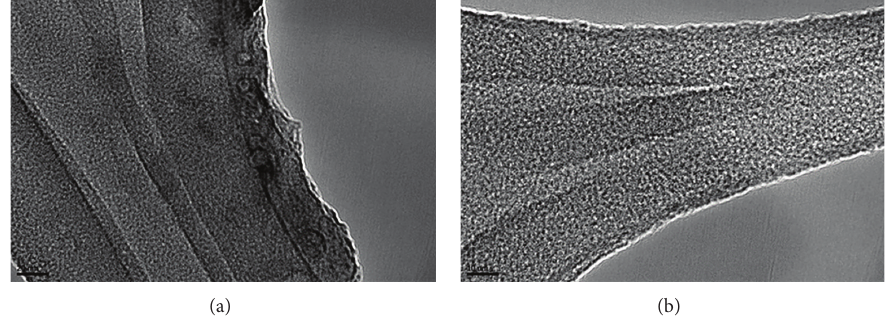
Figure 2: (a), (b) Typical TEM micrographs of some PVA heat-treated